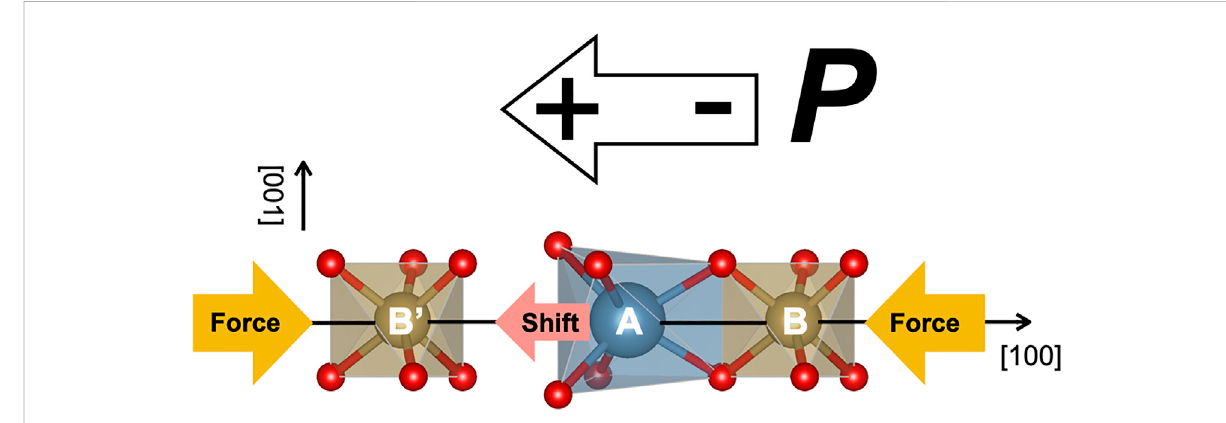
FIGURE 2 Schematic illustration representing the piezoelectricity in LGS-related compounds under the pressure